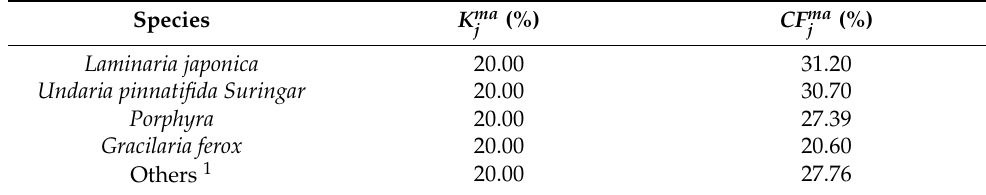
Table 2. Assessment parameters of algae carbon sink